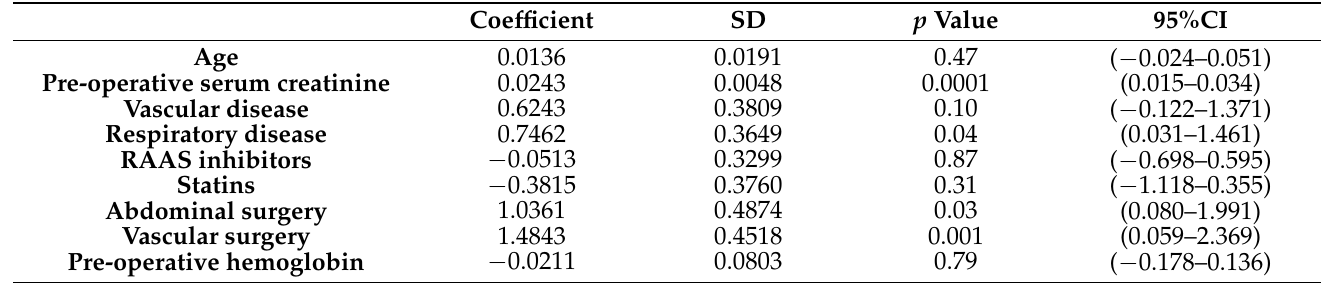
Table 3. Coefficients from the random forest model associated with each variable selected for inclusion in the multivariate analysis.